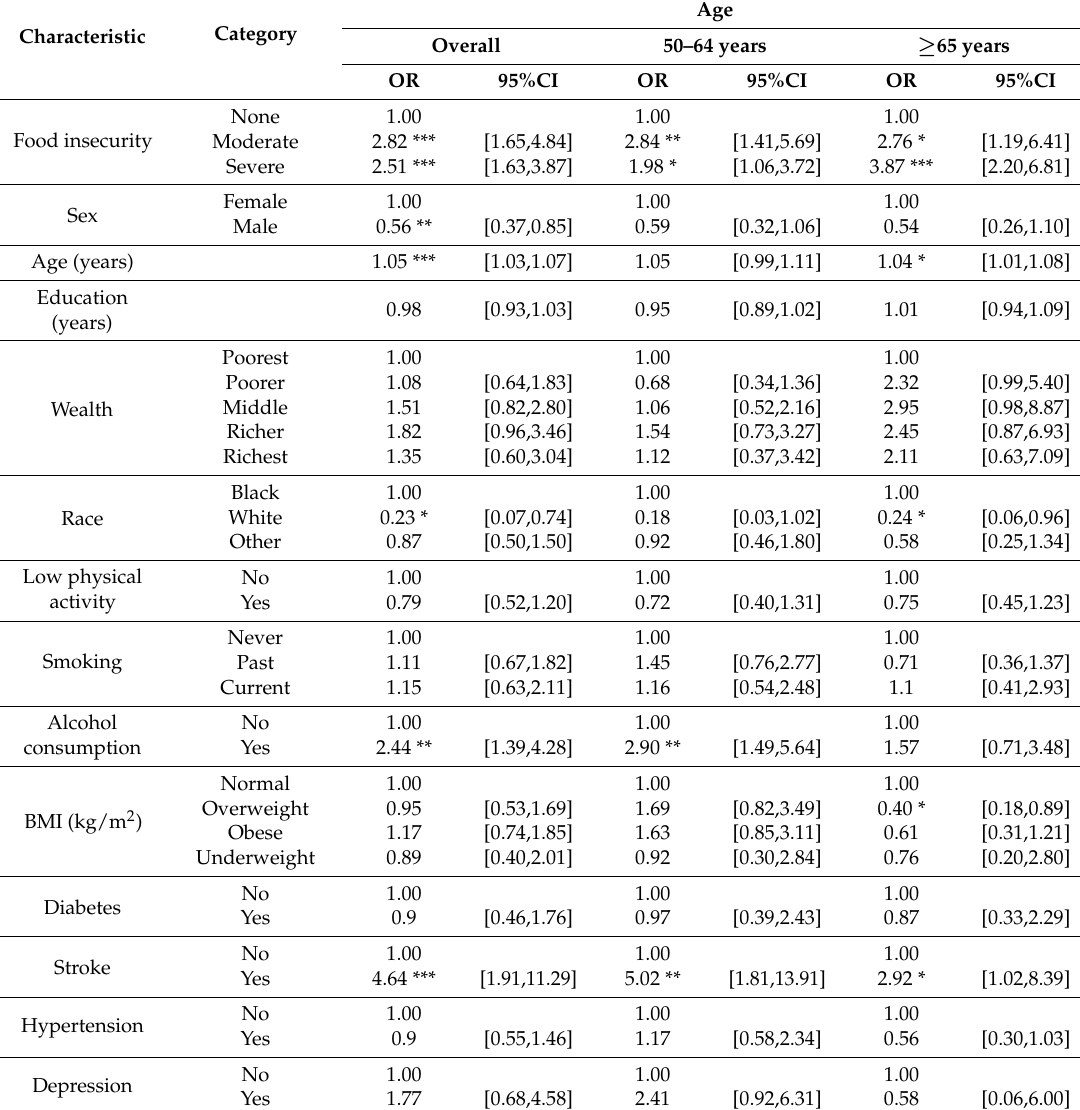
Table 2. Association of food insecurity and other covariates with mild cognitive impairment (outcome) estimated by multivariable logistic